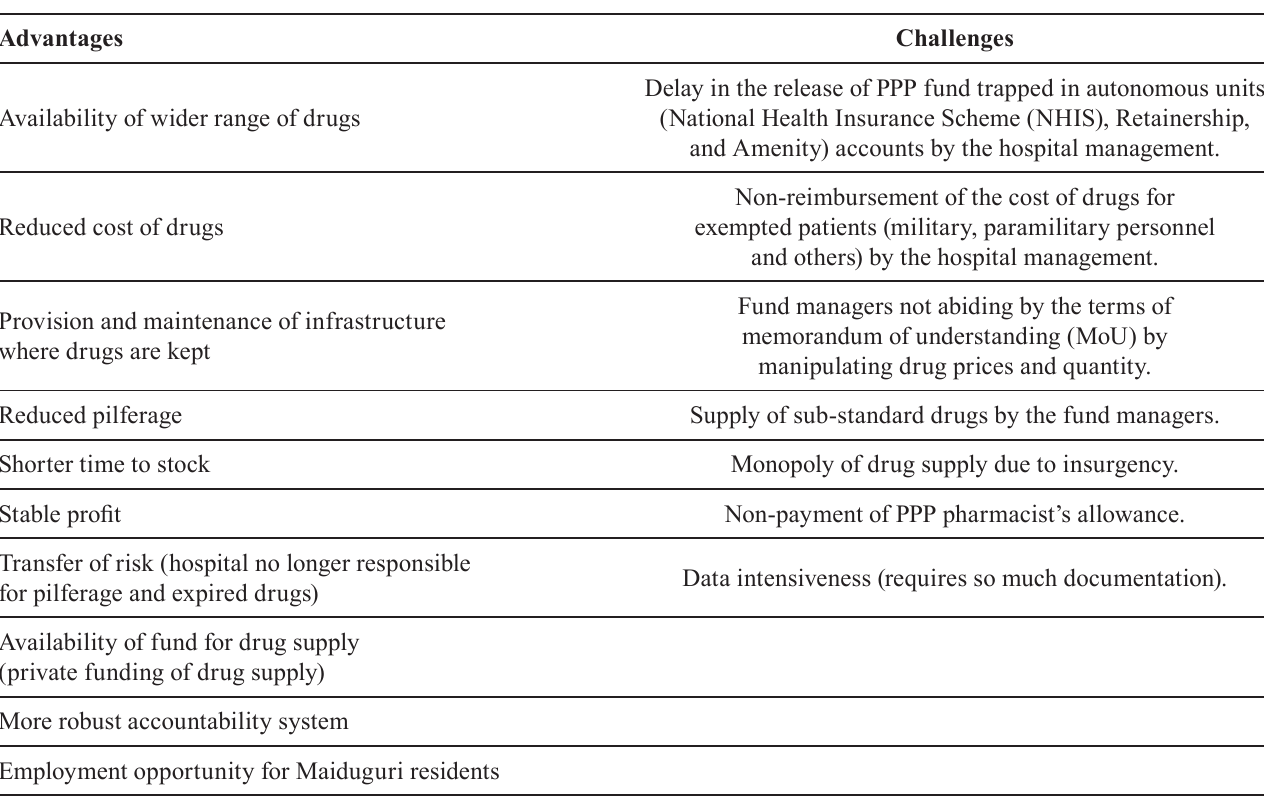
TABLE II – Advantages and challenges of the PPP model in comparison with DRF model in the studied hospital itemized during